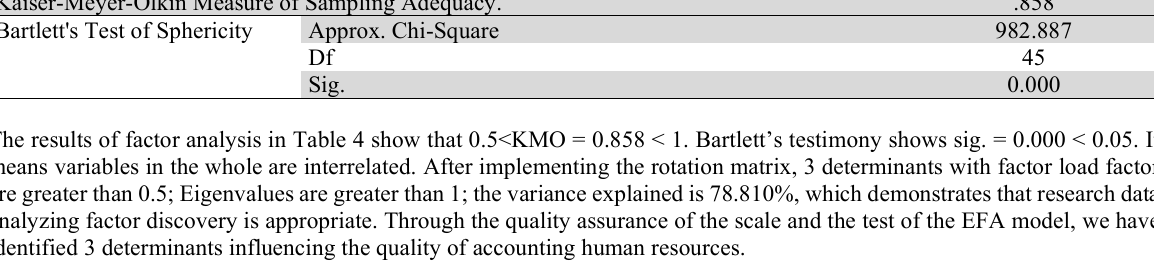
Regression Model Analysis Result